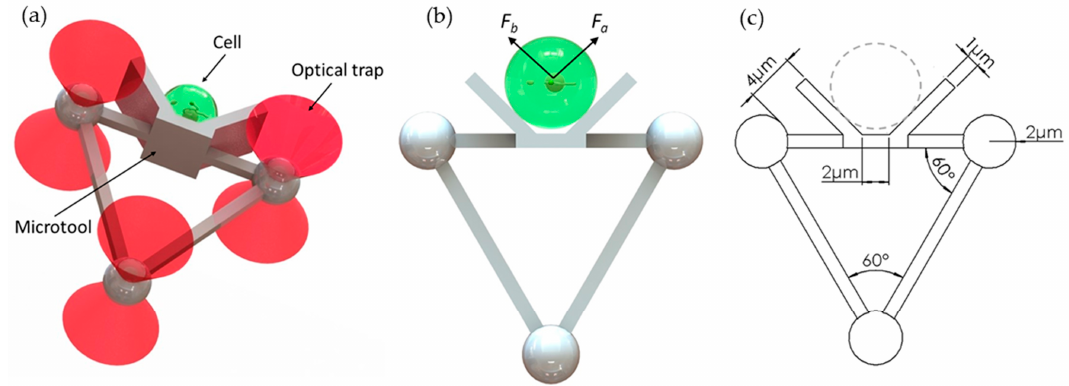
Figure 1. Designed microtool. ( a ) Schematics of the proposed microtool. ( b ) Two push force, namely, Fa and Fb, are generated by the baffles on the left and right sides of the V-shaped head of the microtool. ( c ) Dimensions of the microtool.